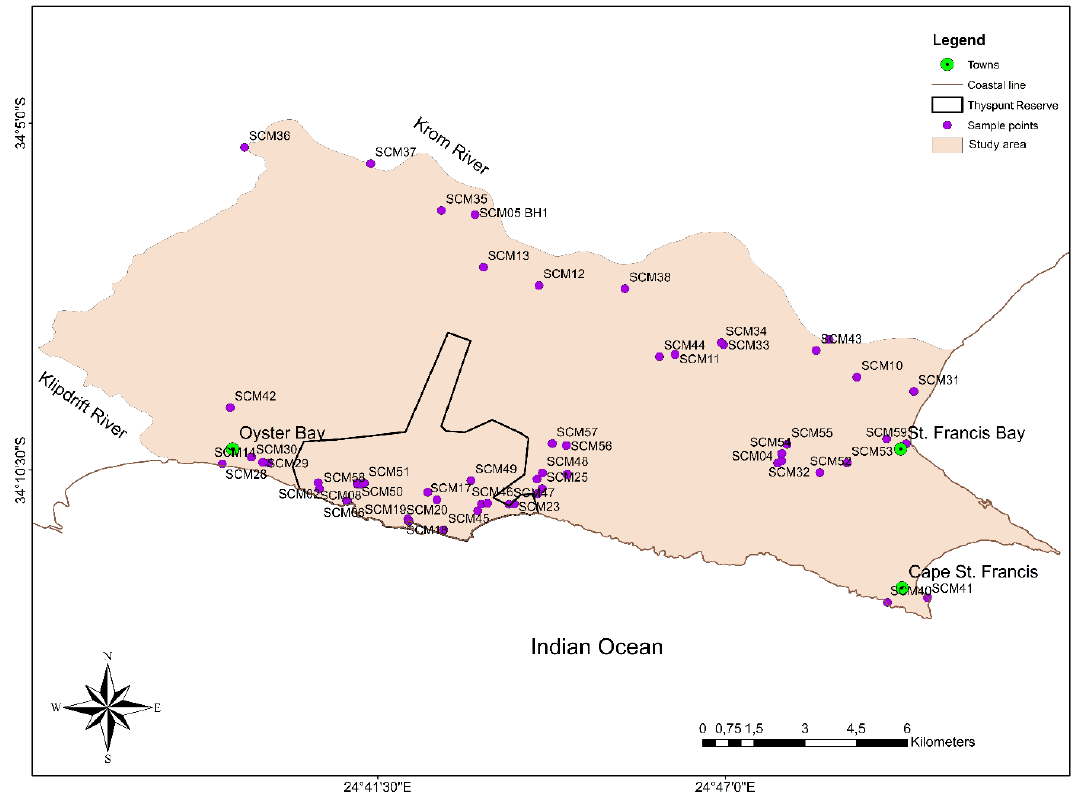
Figure 4. Location of water sampling points within the study area.